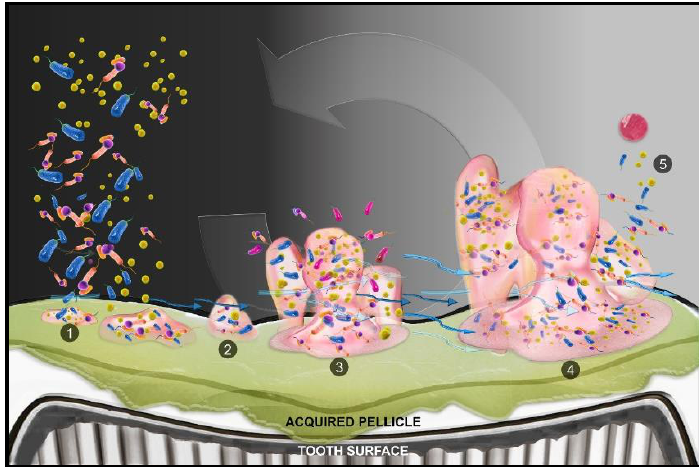
Figure 2. Cycle of biofilm development on the tooth surface. ( 1 ) Free swimming bacterial cells alight on the tooth surface, conditioned with pellicle derived from salivary proteins, and form clusters. ( 2 ) Collected cells begin the production of a gooey matrix and cellular signalizing (quorum sensing (QS)) promotes multiplication and colonization. ( 3 ) Growth of biofilm leads to the development of chemical and oxygen gradients, accompanied by new cell addition to the colony. Water channels develop and pass through the colony. ( 4 ) Cells and extracellular polymer substance (EPS) detach from the existing colony. (5) Free swimming cells rejoin the microbiome or reinitiate the same process, and expansion of growth of the biofilm